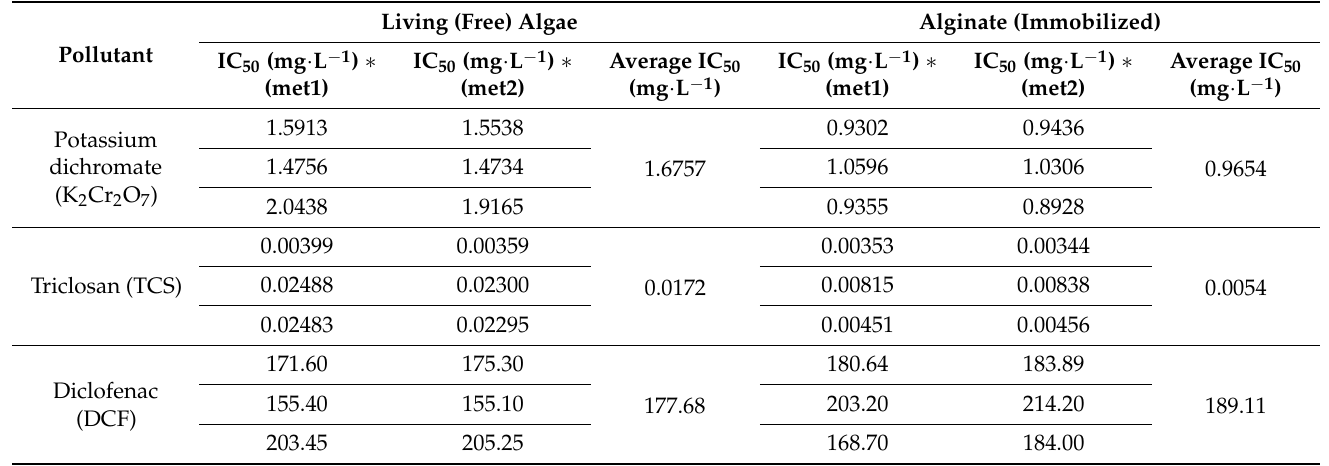
Table 4. IC 50 measured on R. subcapitata (free vs. immobilized